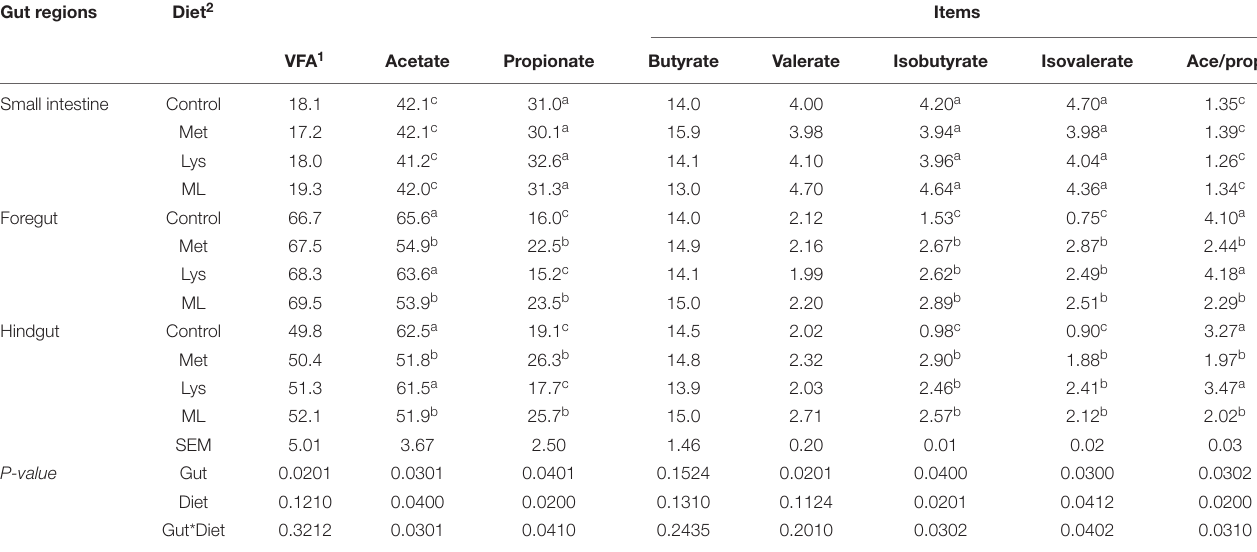
TABLE 3 | Fatty acid metabolites in gut regions of goats supplemented with amino acid. Gut